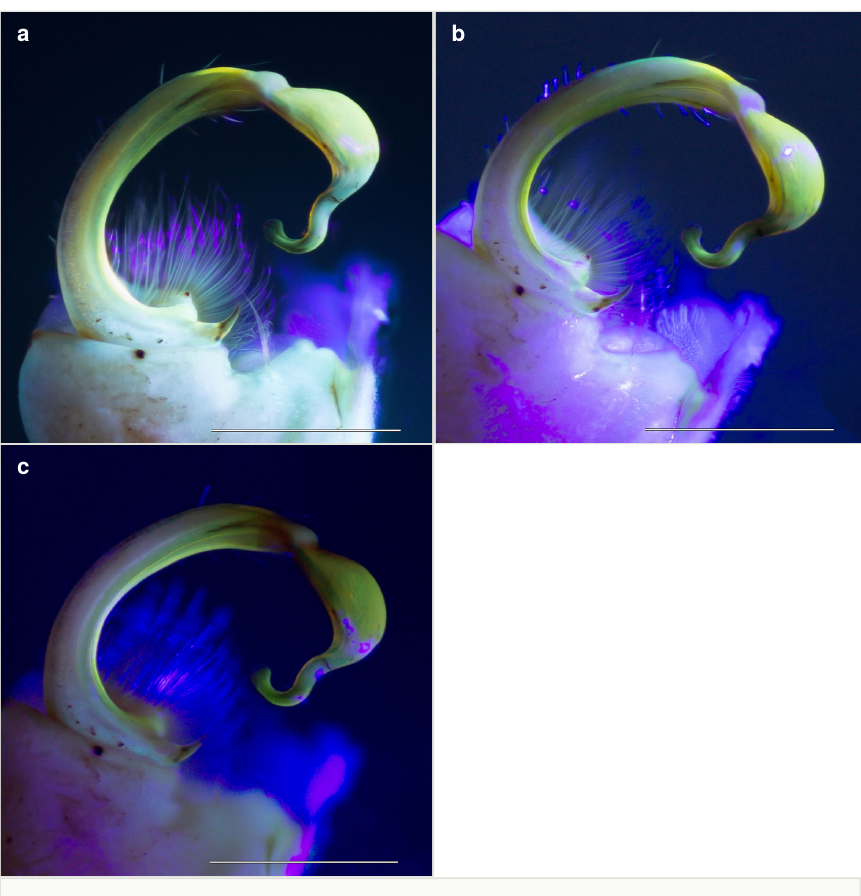
Figure 5. Images of the left gonopod from a male Brachoria sheari illuminated with di ff erent light sources. Scale bar = 1